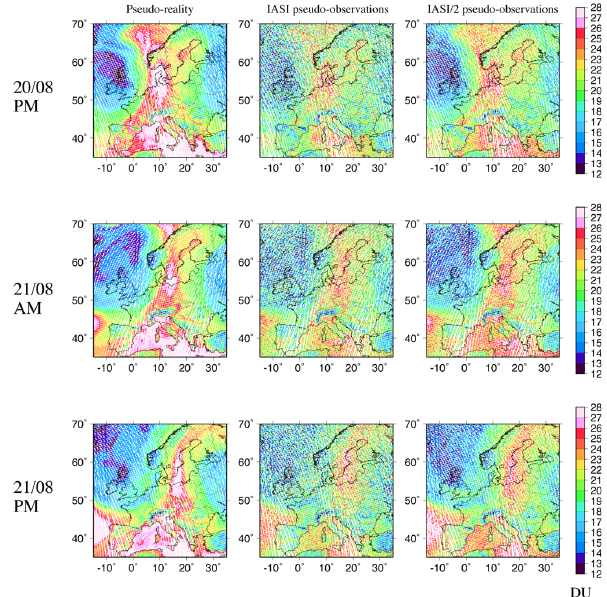
Fig. 9. Same as Fig. 8 but for 20 August 2009 PM–21 August 2009